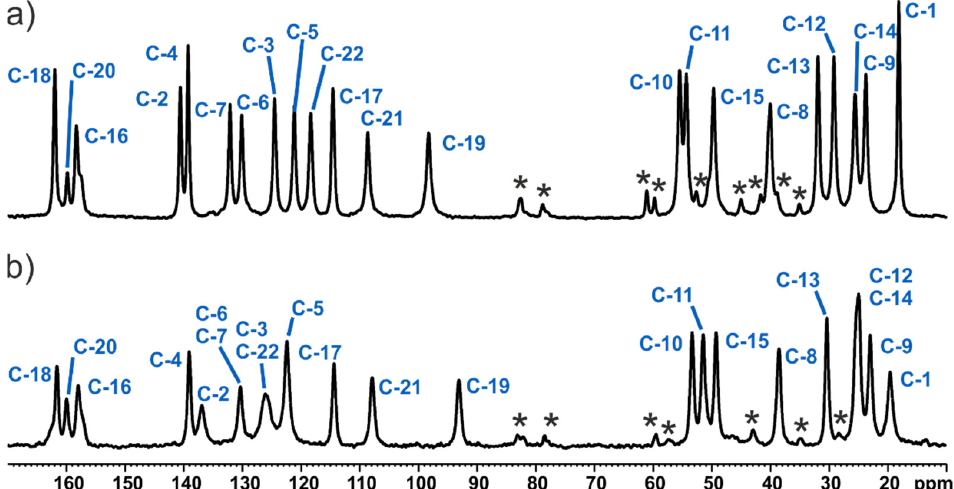
Figure 6. 13 C CP MAS NMR spectra of MBS ( a ) and MBS HCl ( b ) recorded at a spinning rate of 8 kHz at an ambient temperature. Asterisks indicate spinning sidebands.